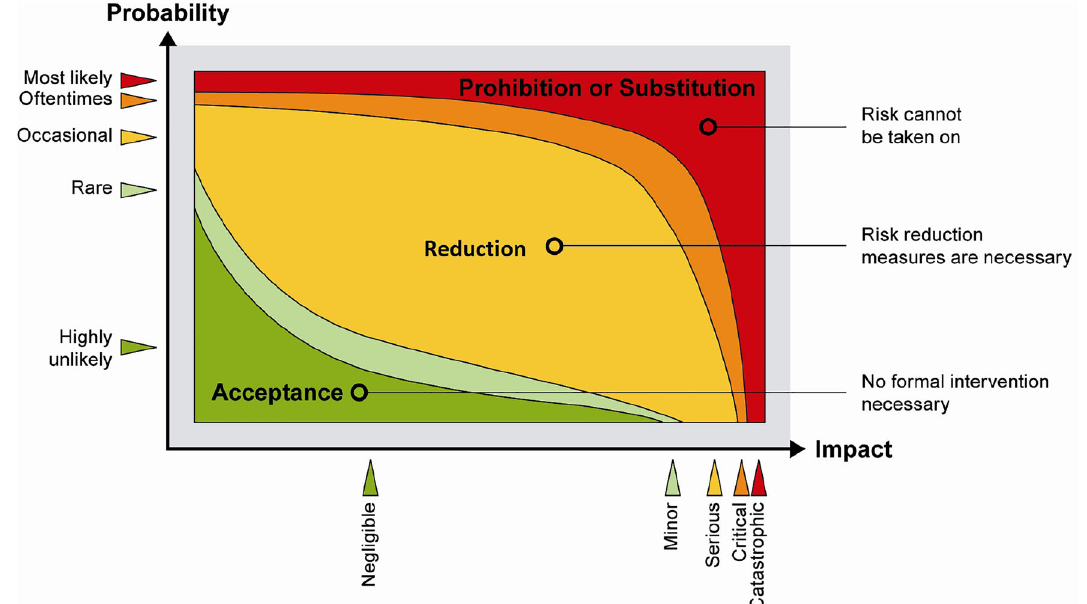
Fig. 2 Risk areas: intolerable red, tolerable amber, acceptable green Source : Renn